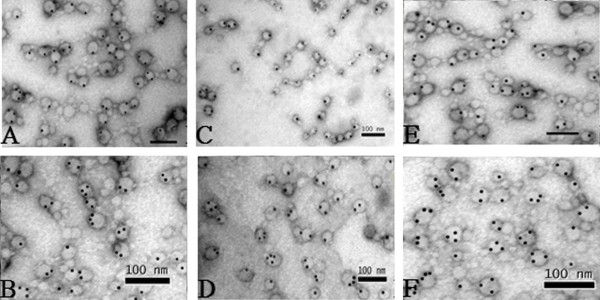
The comparison of immunogold labeling of hepatoma G2 cells treated with or without MS-275. After treatment with MS-275, heat shock protein (HSP)70, MICA, and MICB molecular colloidal gold particles increased in exosomes with statistical significance (P < 0.01). (A) HSP70 protein without drug. (B) HSP70 protein treated with drug. (C) MICA protein without drug. (D) MICA protein treated with drug. (E) MICB protein without drug. (F) MICB protein treated with drug.